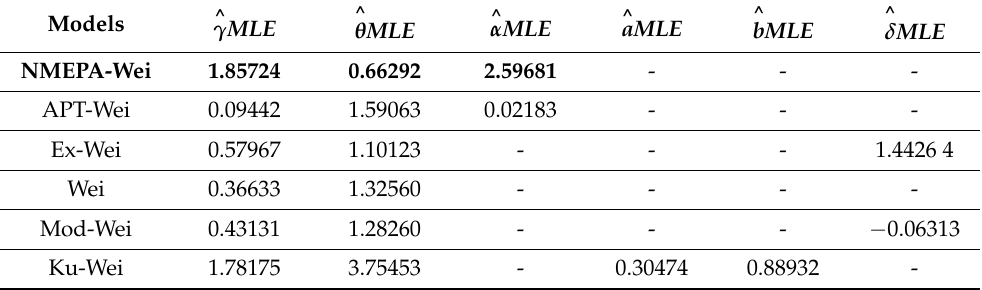
ˆ ˆ ˆ ˆ ˆ ˆ aMLE , bMLE , and γ MLE , θ MLE , α MLE , δ MLE of the competitive models